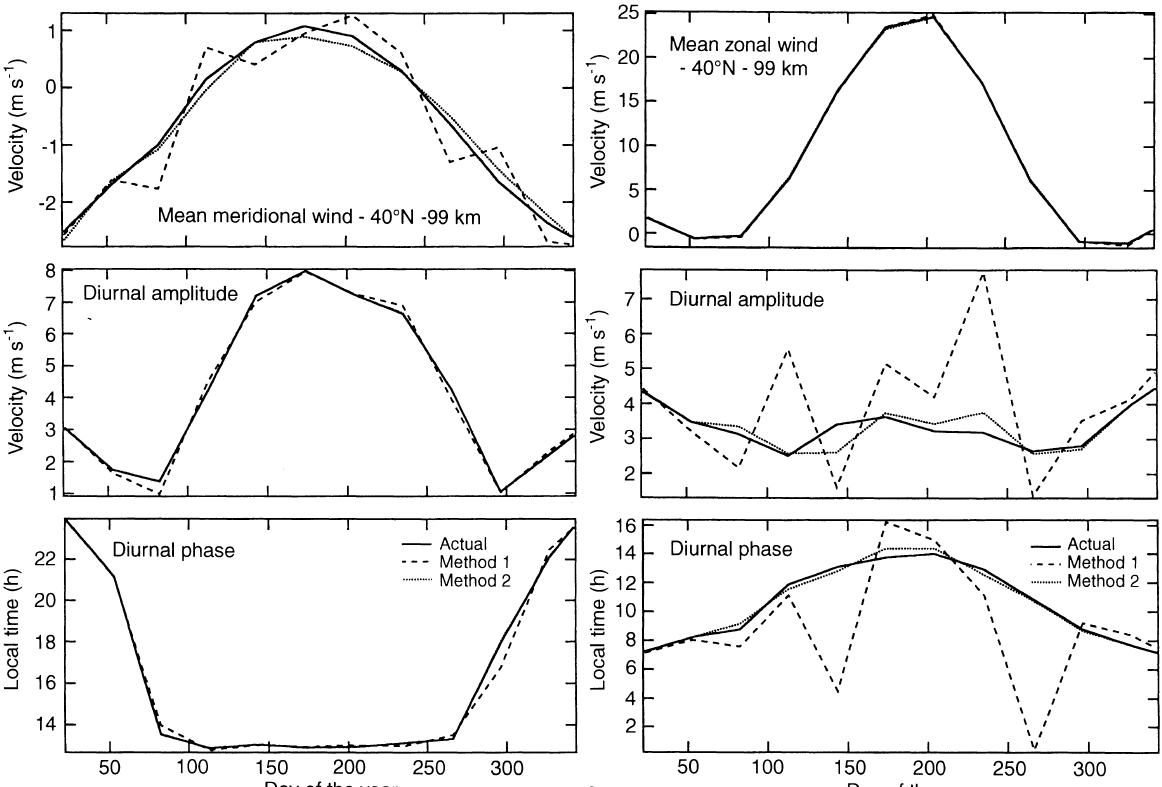
Fig. 2a,b. Simulated data and Method 1 and 2 results: a mean, diurnal amplitude and phase of the meridional wind, b mean, diurnal amplitude and phase of the